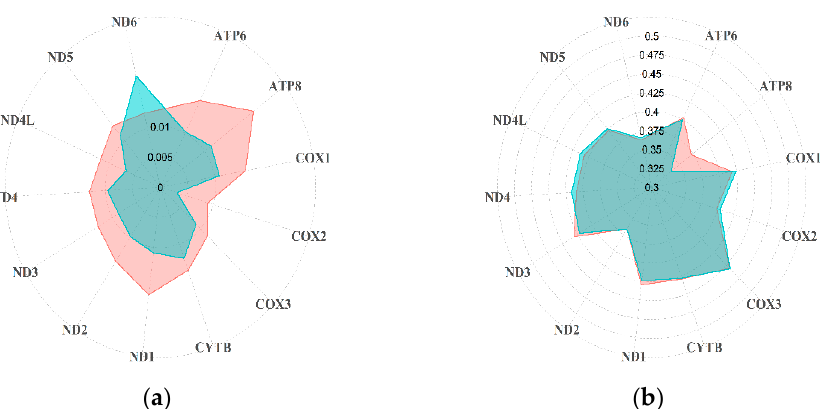
Figure 1. Differences between R. rupicapra (green) and R. pyrenaica (red) in terms of ( a ) nucleotide diversity and ( b ) GC content.